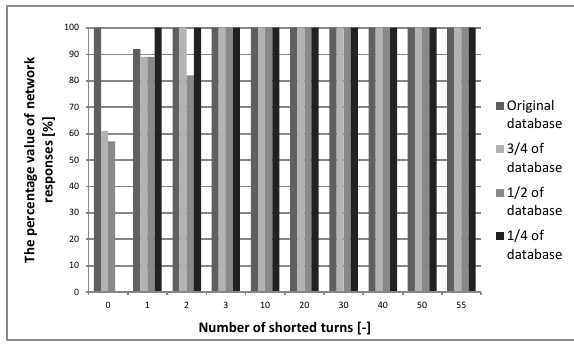
Fig. 1. Network responses for a different training dataset sizes.